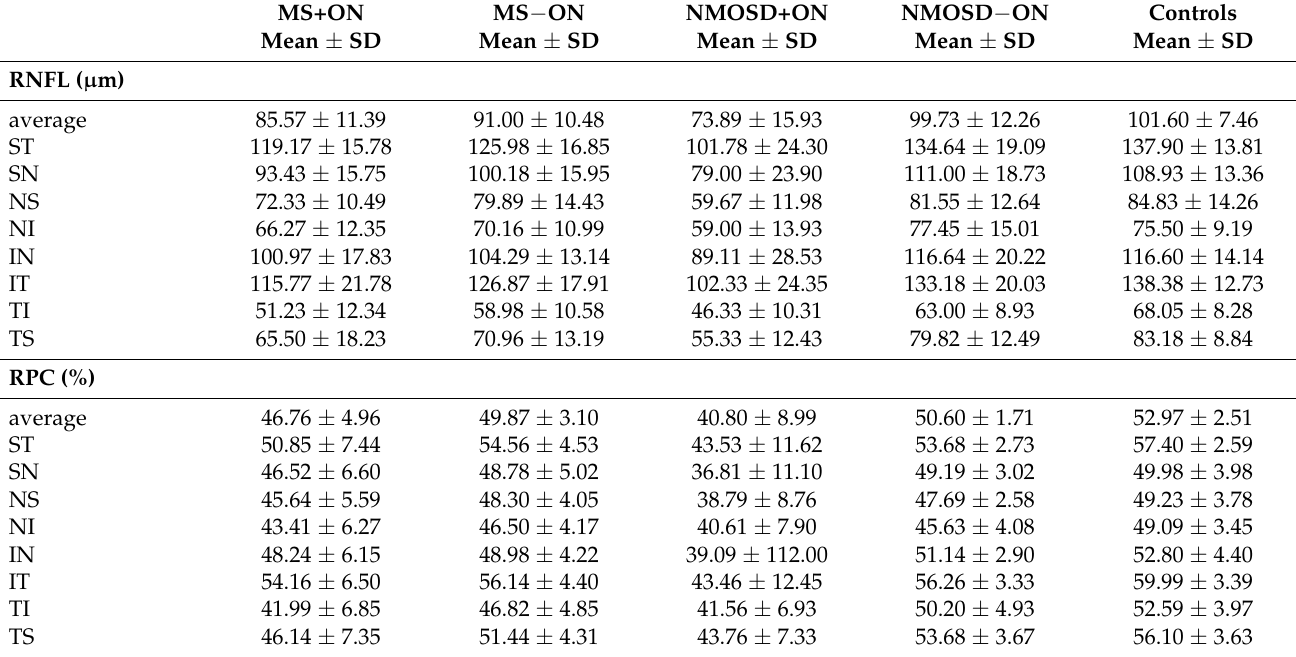
Table 2. Baseline spectral-domain OCT and OCT angiography results of patients and controls.